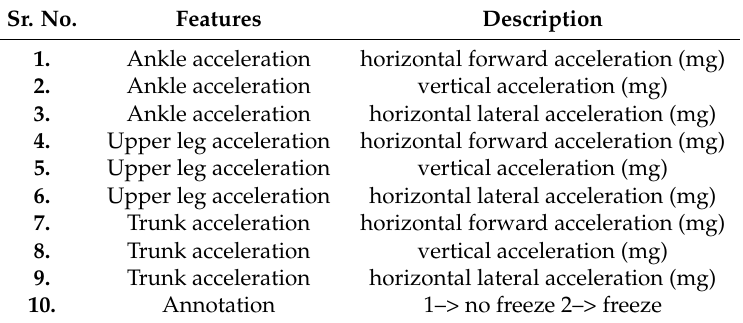
Table 2. Description of the